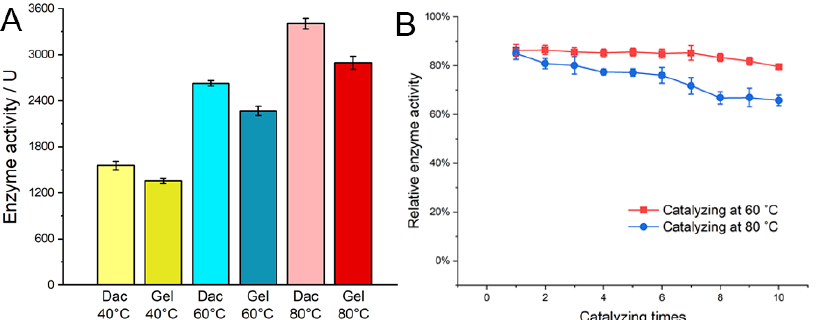
Figure 5. Results of hydrogels working at high temperature. ( A ) Enzyme activities of hydrogels and crude Dac solution working at 40 °C, 60 °C, and 80 °C for the first round of catalyzing. ( B ) Relative enzyme activities of hydrogels working at 60 °C and 80 °C during 10 rounds of recycling. Crude Dac solution was used as the reference of enzyme activity.